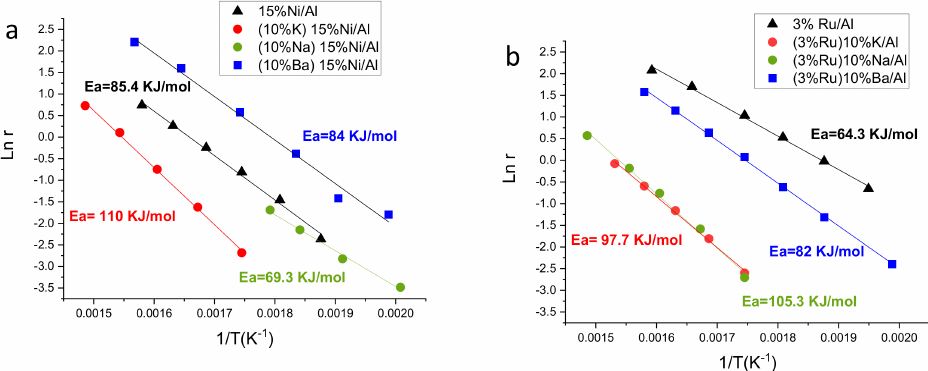
Figure 2. Arrhenius plot with apparent activation energies for catalysts of: ( a ) Ni series and ( b ) Ru series.